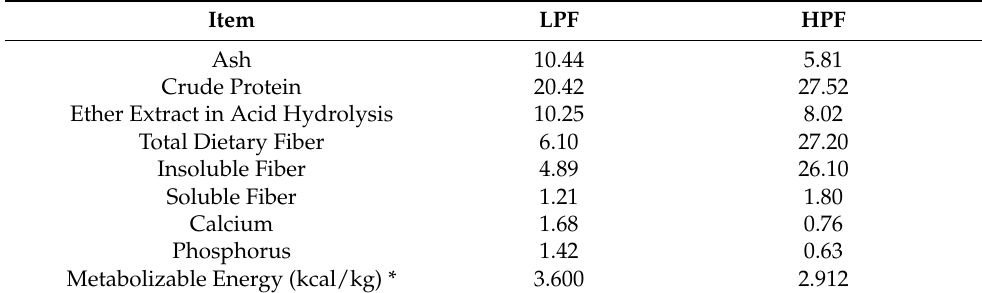
Table 1. Analyzed chemical composition (%, dry matter basis) of the lower protein and fiber diet (LPF) and higher protein and fiber diet